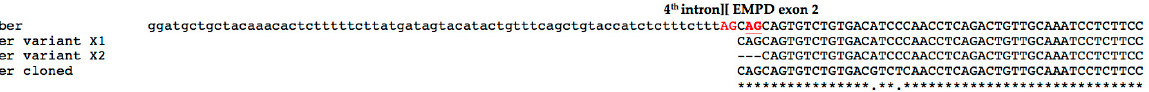
Figure 4. Nucleotide and deduced amino acid sequences of the gene encoding T. bernacchii pIgR. The start and stop codons are given in bold red, and the polyadenylation signals located downstream of the stop codon are underlined. The boundaries of the signal peptide (SP); the D1, D2, and EMPD domains; and the transmembrane (TM) and cytoplasmic (CYT) regions are indicated by square brackets above the nucleotide sequence. Polymorphic sites are highlighted in green. Amino acid residues are reported in one-letter code below the nucleotide sequence. The large (L) and the small (S) loops are indicated above codons for the cysteine residues forming them. N- glycosylation sites defined by the NXS/T sequons are bold and underlined. The numbering of nucleotides and of amino acids residues is reported above and below each sequence, respectively.